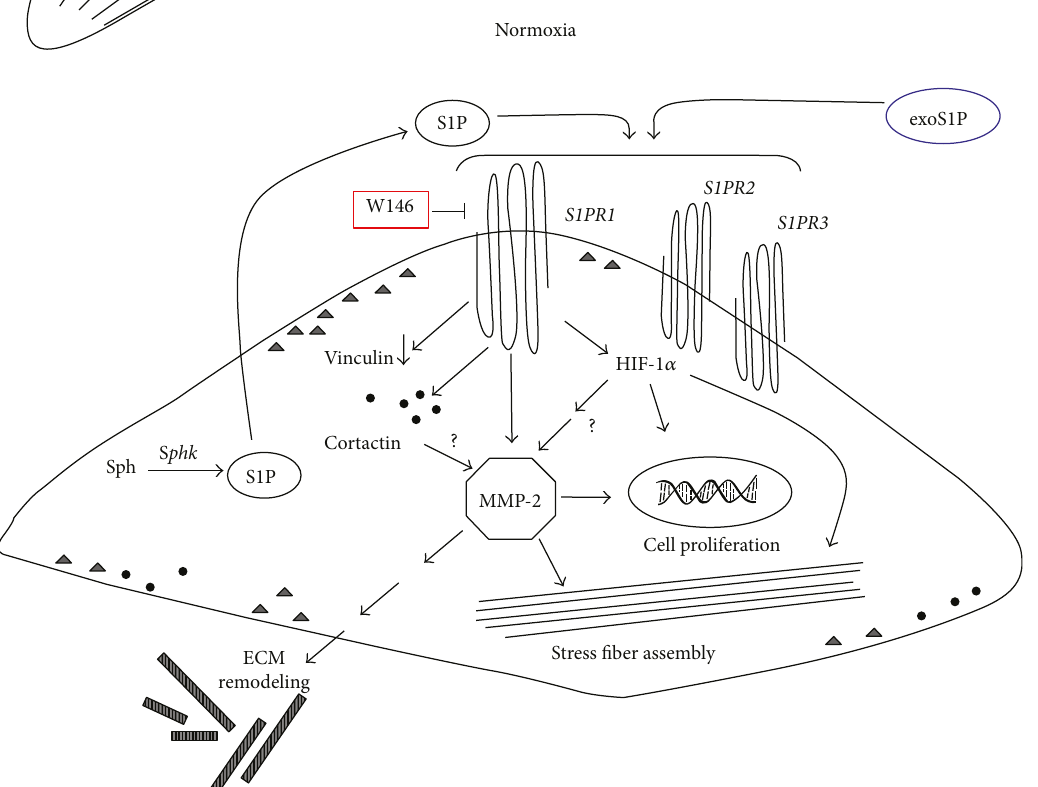
Figure 8: Schematic drawing summarizing the main conclusions of the